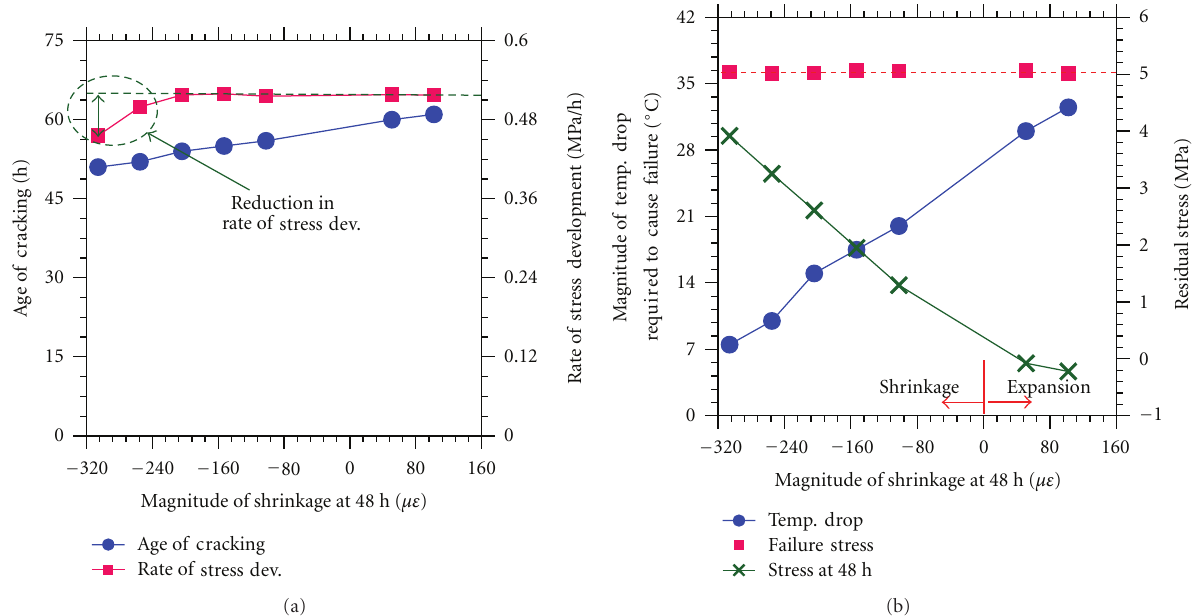
Figure 14: Influence of autogenous shrinkage on (a) the stress development and the age of cracking, (b) the magnitude of temperature reduction, stresses at 48h, and the average section stress at failure in dual ring